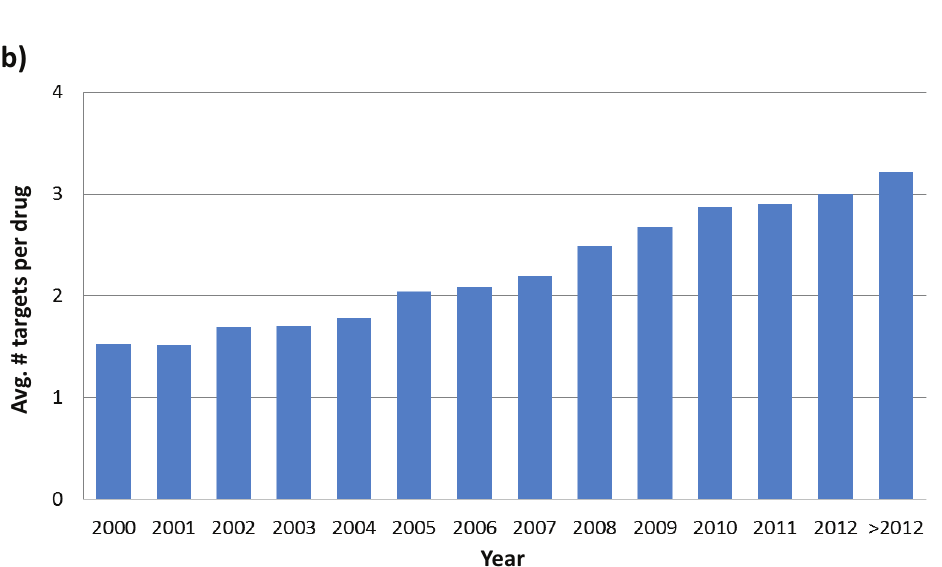
Figure 6. Monitoring drug promiscuity over time. ( a ) Box plots capture the distribution of the number of targets per drug in different years. Each box plot reports the smallest value (bottom line), lower quartile (lower boundary of the box), median (thick horizontal line), upper quartile (upper boundary of the box), and the largest value (top line). ( b ) Reported are average numbers of targets per drug in different